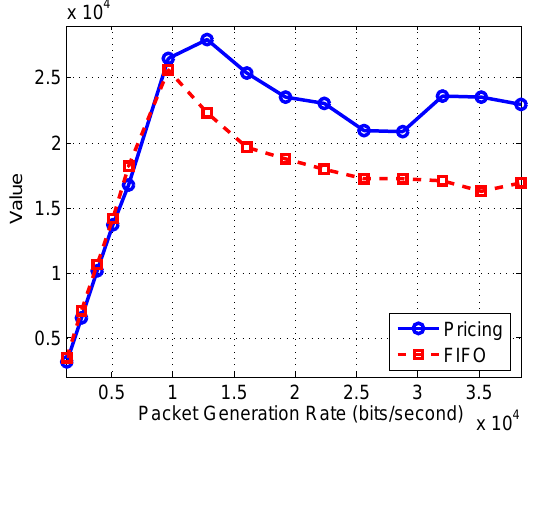
Figure 19. Comparison of value for random